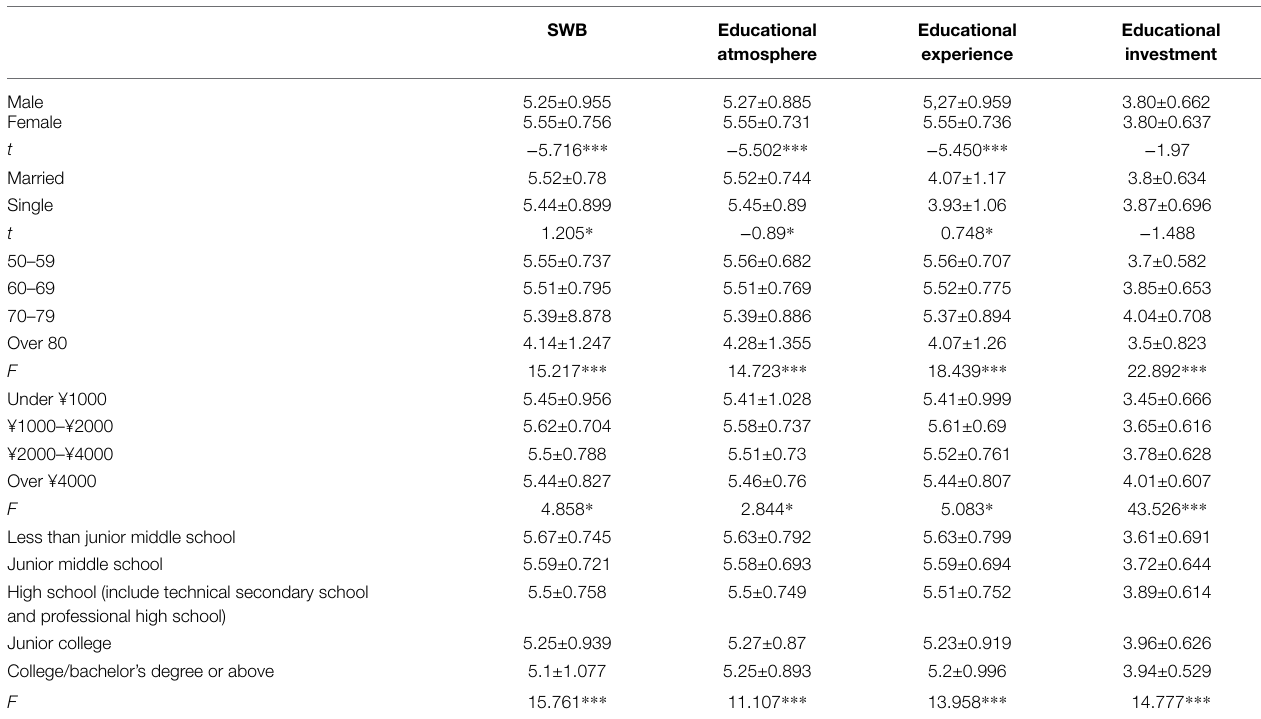
TABLE 6 | Descriptive